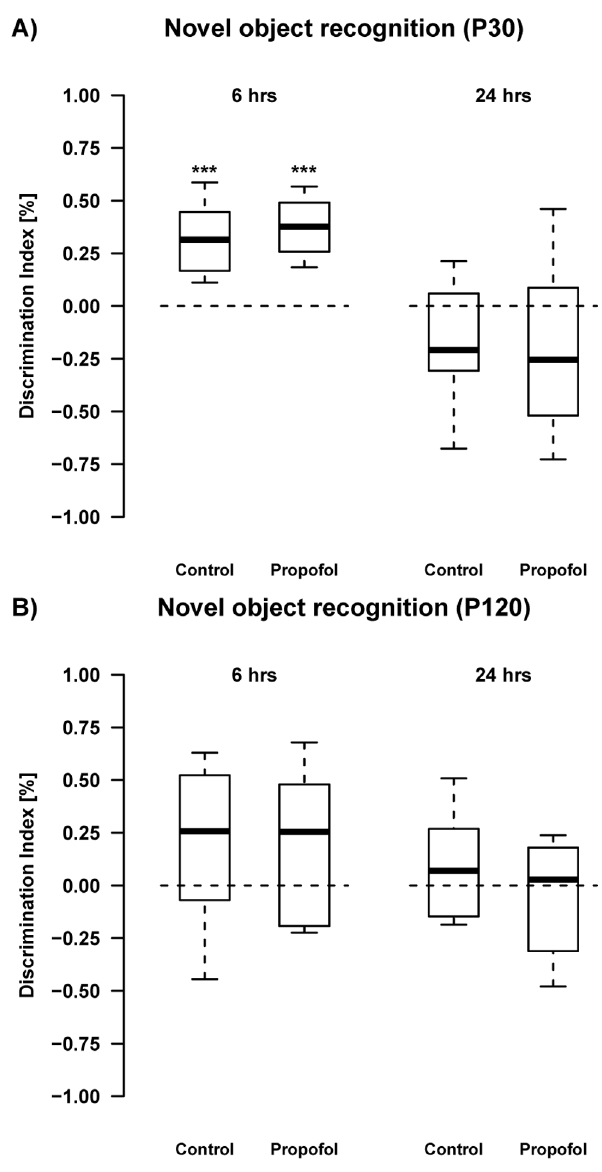
Figure 6. Novel object recognition on P30 and P120: At the age of 30 days, both propofol treated animals (t(7) = 7.45, ***q=4.3 6 10 2 4 ) and controls (t(10)=6.30, ***q=3.6 6 10 2 4 ) spent significantly more time with the novel object indicating their ability to discriminate the novel from the old object. Propofol (t(7) = 2 1.44, q = 0.192) as well as control animals (t(10)= 2 1.92, q=0.168) failed to do so after a 24 hrs inter-trial interval. At P120 both groups spent a random amount of time with either of the objects after 6 hrs and also after a 24 hrs interval, indicating that they were unable to remember the old object. (n controls =12 animals, n propofol =8 animals). period of ongoing physiological elimination of brain cells, can promote apoptotic death.